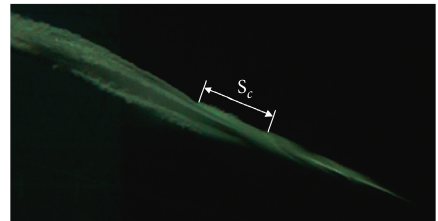
Figure 3: An experimental photograph of a SV.